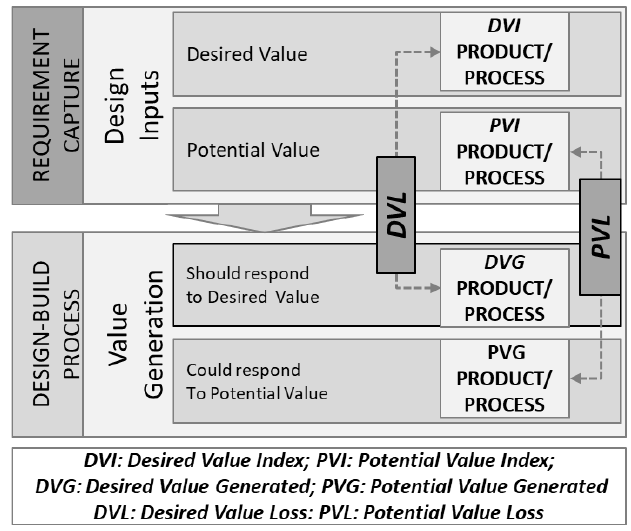
Figure 1. Graphical overview of the VAM [20].